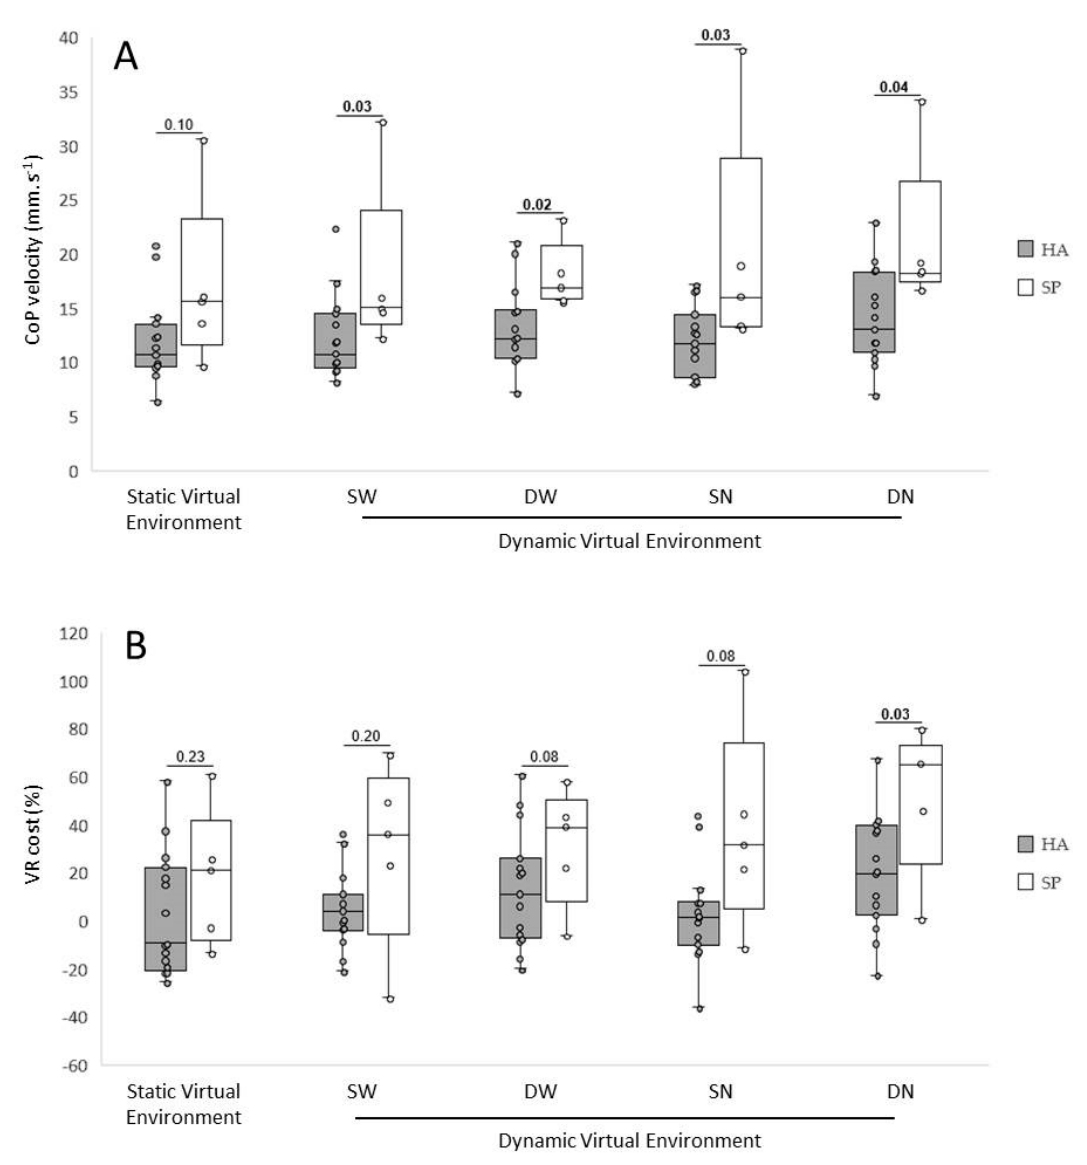
Figure 2. CoP velocity ( A ) and Vrcost ( B ) between HA (healthy adults) and SP (stroke patients). CoP: Center of Pressure; Vrcost: Virtual Reality cost; D: dense; N: Narrow; S: sparse; W: Wide.